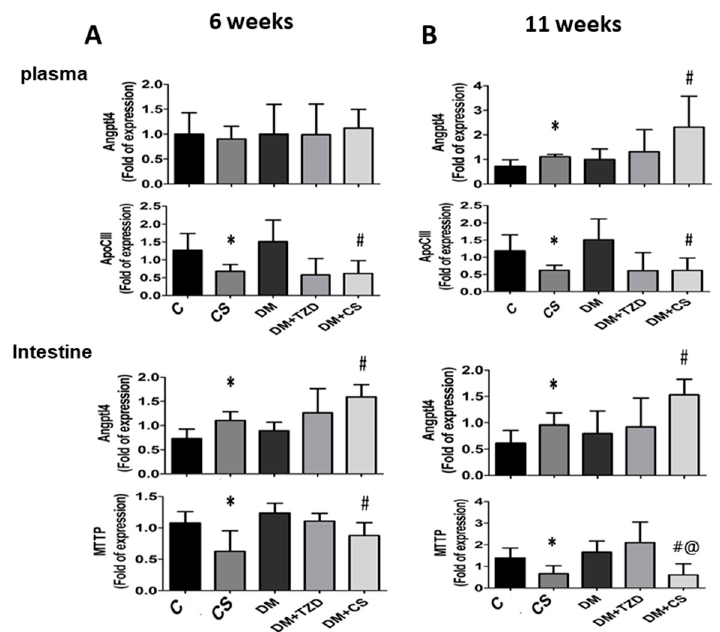
Figure 4. Effects of chitosan on metabolic signaling protein expression in the plasma and intestine of diabetic rats with different feeding durations. ( A ) 6-week feeding duration; ( B ) 11-week feeding duration. The protein expressions for Angptl4, ApoCIII, MTTP, and β -actin (internal control) were determined by Western blot analysis. The densitometrical quantification is shown. Results are expressed as mean ± S.D. for each group (n = 4–6). Significant difference ( p < 0.05) analyzed by one-way ANOVA and two-tailed Student’s t -test. *: versus C; #: versus DM; @: versus DM + TZD. The changes of lipoprotein lipase (LPL) activity and lipolysis rate in perirenal adipose tissues were also examined. As shown in Figure 5, the LPL activity was significantly increased in both the DM + TZD and DM + CS groups compared to the DM, DM + CS, and CS groups at 6-week feeding duration; but LPL activity was significantly decreased in CS (versus C) and DM + CS (versus DM) groups, and still increased in the DM + TZD group (versus DM) at an 11-week feeding duration. There was a significant decrease in